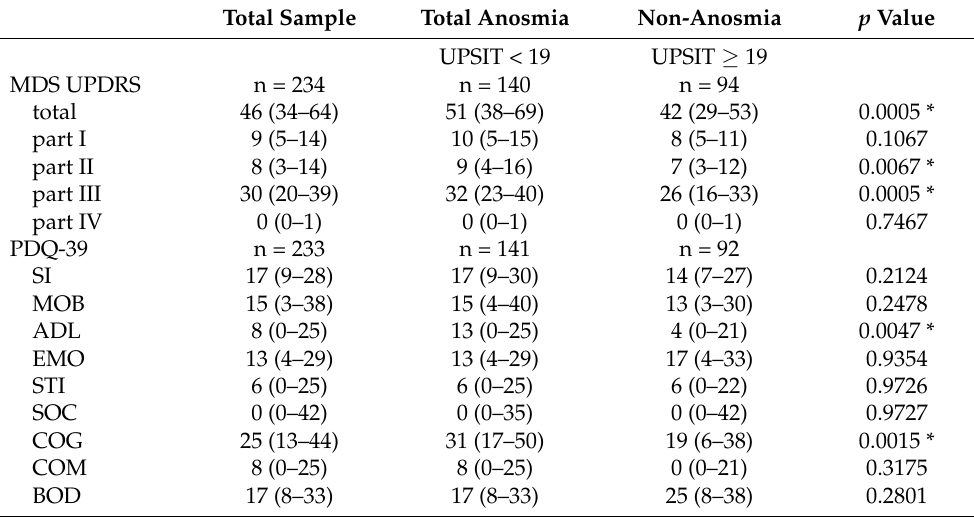
Table 2. Comparison of MDS UPDRS and PDQ-39 between the two groups.